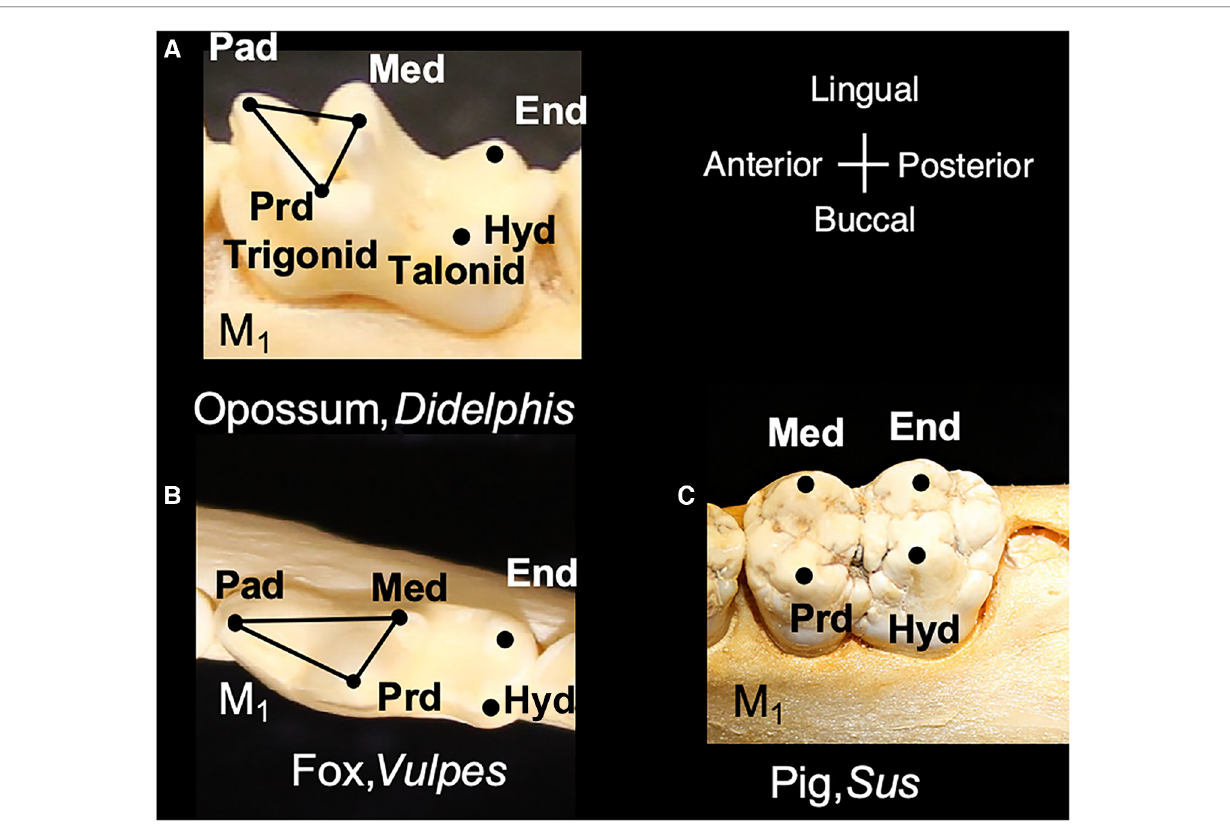
FIGURE 2 Modern mammals include molar shapes that have evolved from the tribosphenic shape. ( A ) Lower molar of Didephis , showing the location of the trigonid and talonid cusps. ( B ) Lower molar of the fox, Vulpes , showing emphasis of the paraconid (pad) and protoconid (prd) into a carnassial blade and reduction of the metaconid (med). ( C ) Lower molar of the pig, Sus , showing the absence of the paraconid and emphasis of the remaining trigonid cusps (med and prd) and talonid cusps (hypoconid, hyd, and entoconid, end). Teeth are not shown to